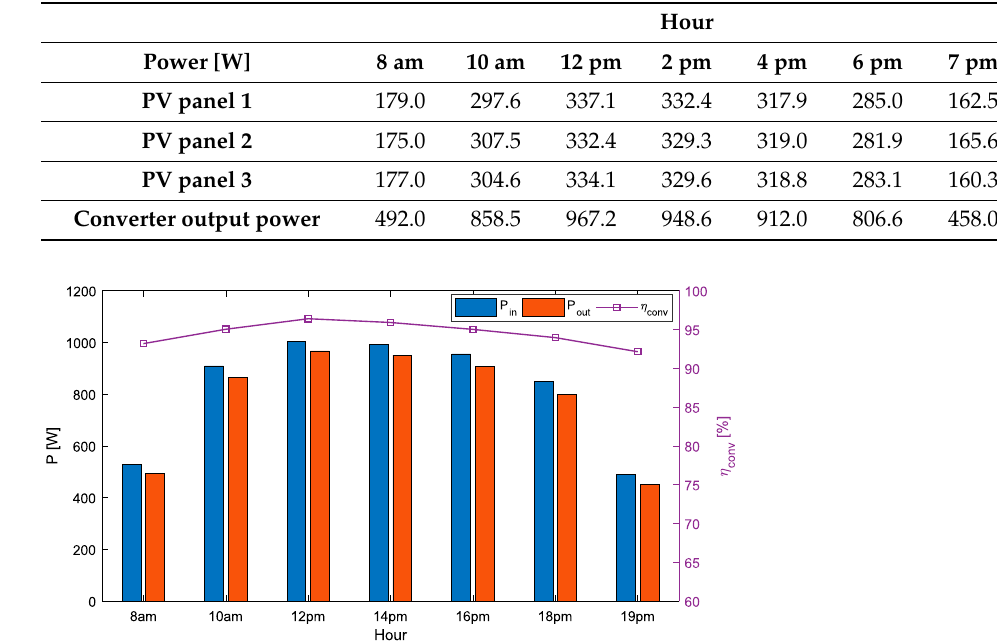
Figure 24. Experimental efficiency results.